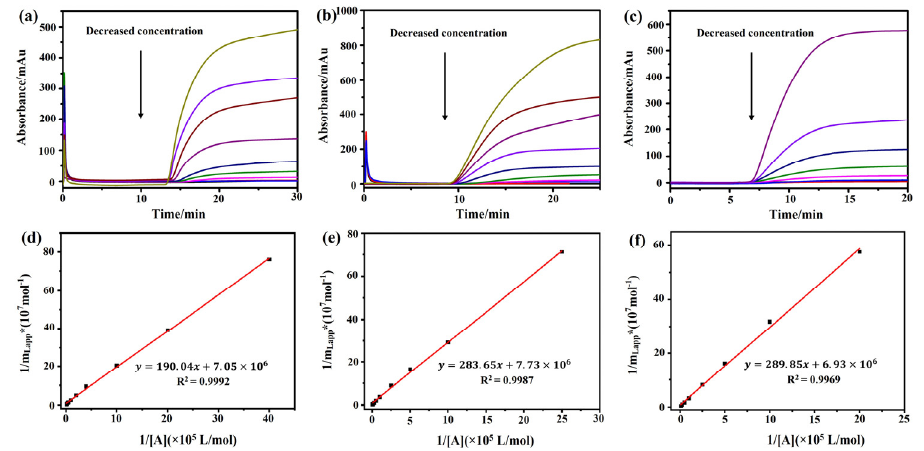
Figure 4. Analysis of the association constants of atropine sulfate, pilocarpine, and ( − )-scopolamine hydrochloride with M3R by frontal a ffi nity chromatography. The breakthrough curves of atropine sulfate ( a ), pilocarpine ( b ), and ( − )-scopolamine hydrochloride ( c ) by the M3R-immobilized column. The regression curves of atropine sulfate ( d ), pilocarpine ( e ), and ( − )-scopolamine hydrochloride ( f ) obtained by plotting 1/ m Lapp vs. 1/[ A ]. Table 1. The association constants ( K A ), numbers of binding sites ( m L ), and dissociation rate constants ( k d ) of atropine sulfate, pilocarpine, and ( − )-scopolamine hydrochloride determined by M3R-immobilized column chromatography.